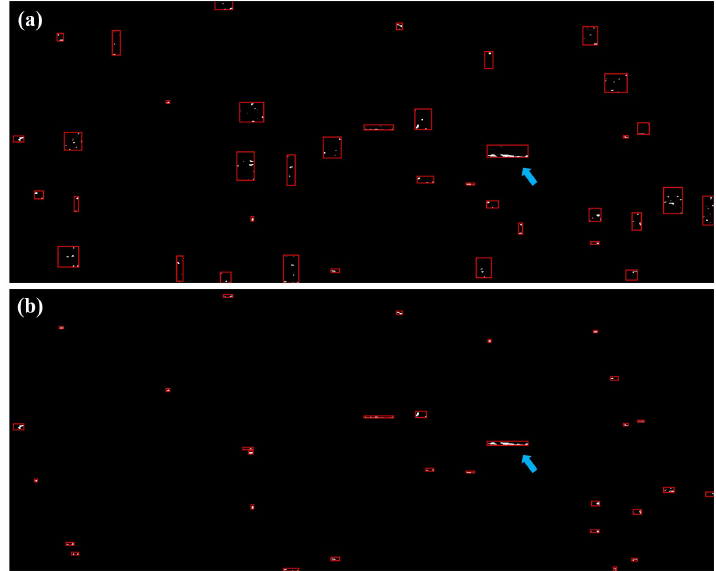
Figure 15. Subfigure ( a , b ) are the result of applying the conventional DBSCAN and modified DBSCAN method to 18th image respectively. Each cluster is bounded with the red rectangle according to minimal bounding box parameter. The blue arrow points to the moving